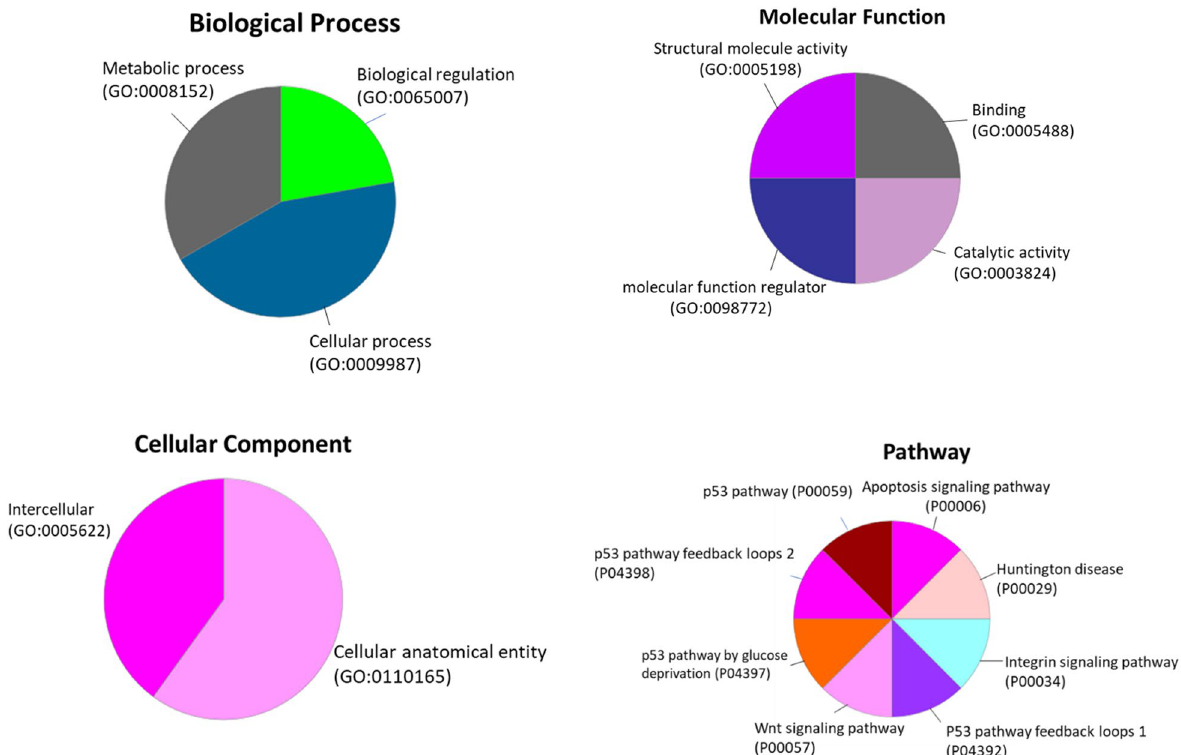
Figure 6. Gene ontology functional enrichment analyses of differentially expressed genes (DEGs) for targeted genes of